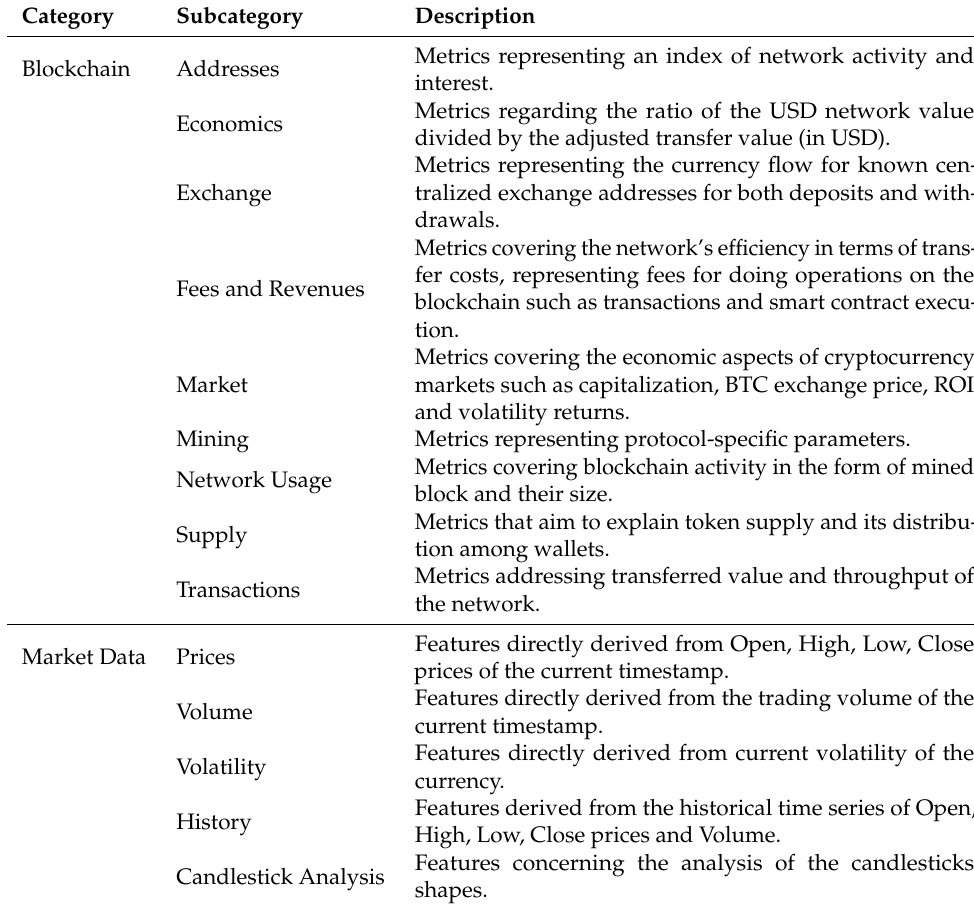
Table 2. Categories and subcategories of the features present in the